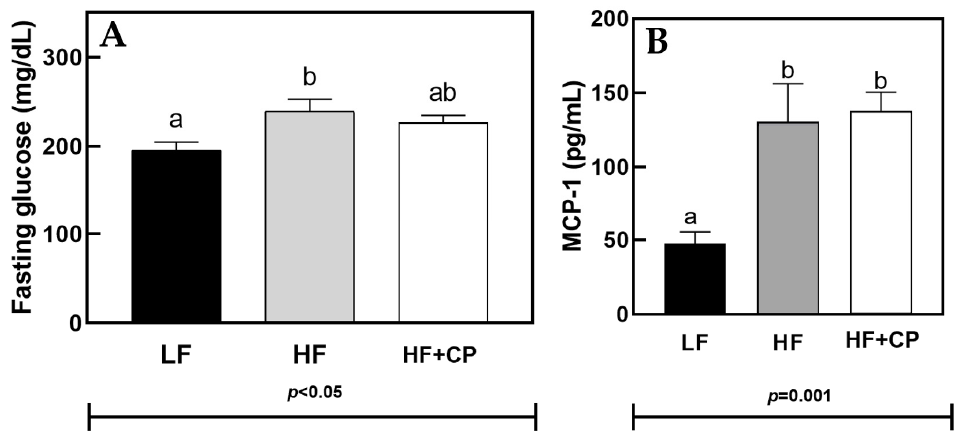
Figure 2. Fasting glucose ( A ) and Serum MCP-1 concentration ( B ) in male C57BL/6J mice fed a LF diet, HF diet, or a HF+CP HF+CP diet for 10 weeks. a,b Groups not sharing the same lowercase letters indicate that one-way ANOVA found significant differences between groups ( p < 0.05). Average ( n = 12 for control groups and n = 8 for experimental group) ± SEM. The serum MCP-1 concentration was statistically higher in HF-fed and HF+CP-fed groups than the LF-fed group ( p = 0.001) (Figure 2B). Total triacylglycerol concentration was statistically greater in HF- and HF+CP-fed groups vs. LF-fed mice ( p < 0.0001) (Figure 3A). Tis is confirmed by visual inspection of corresponding microphotographs of the stained liver tissue (Figure 3B–D).